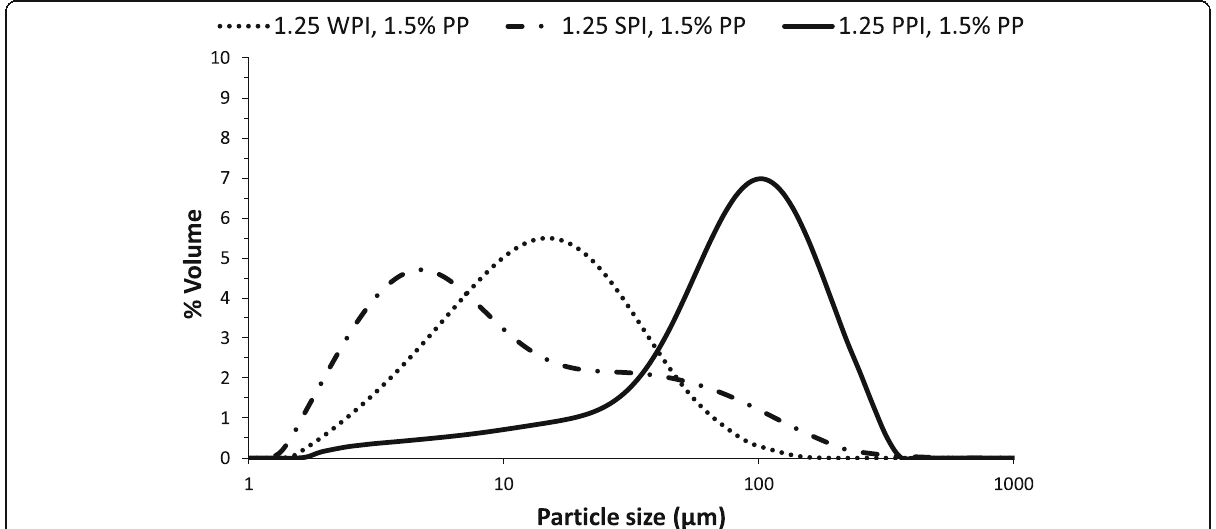
Fig. 5 Particle size distributions of dispersions with 1.25 protein:sucrose ratios and 1.5% PP contents comprised of WPI, SPI, and PPI at 25 °C; (averaged data plotted, n =